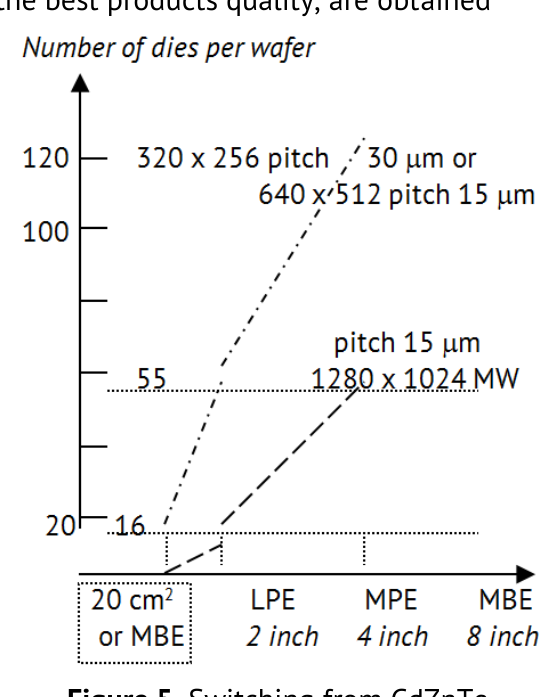
Figure 5. Switching from CdZnTe substrates to those made from Ge can substantially boots the number of dies per wafer (after